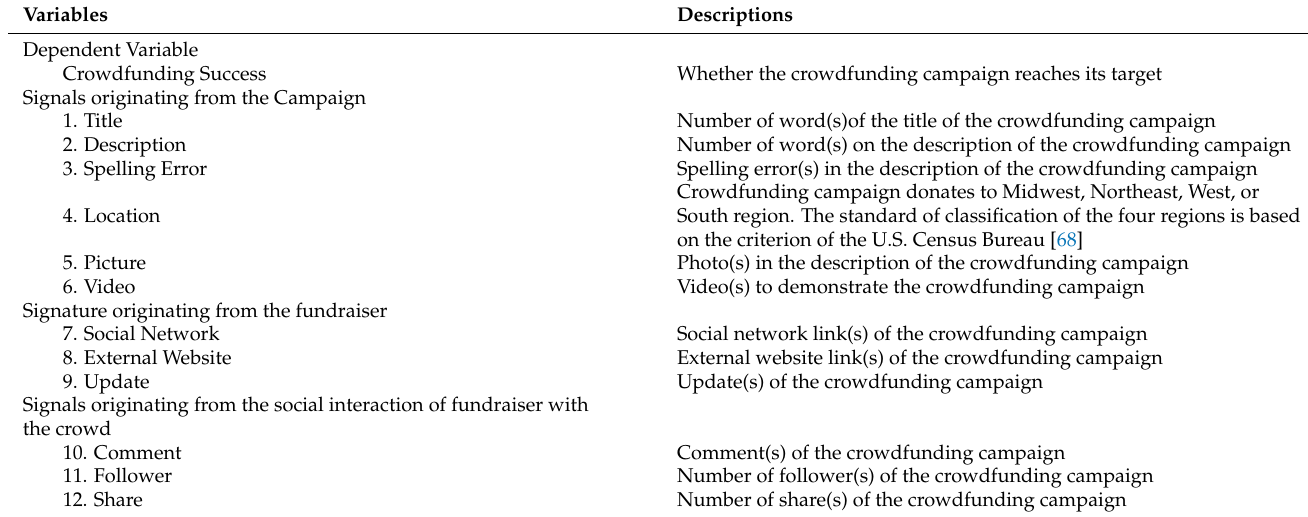
Table 2. The variables and